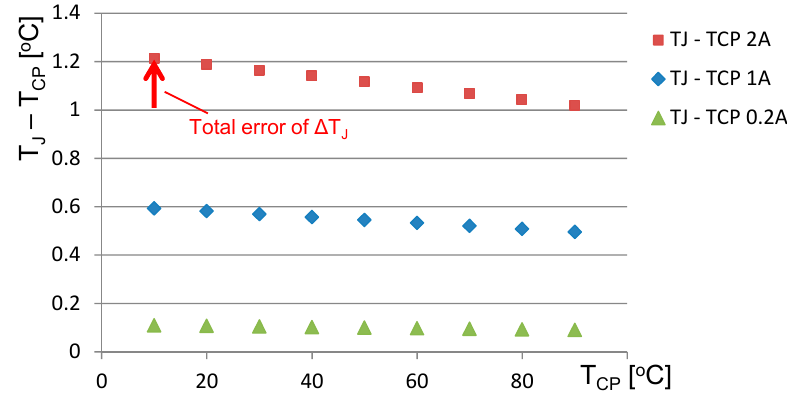
Figure 11. Difference of the actual T J junction temperature of the device presented in Section 2.1 and the T CP cold plate temperature during calibration.